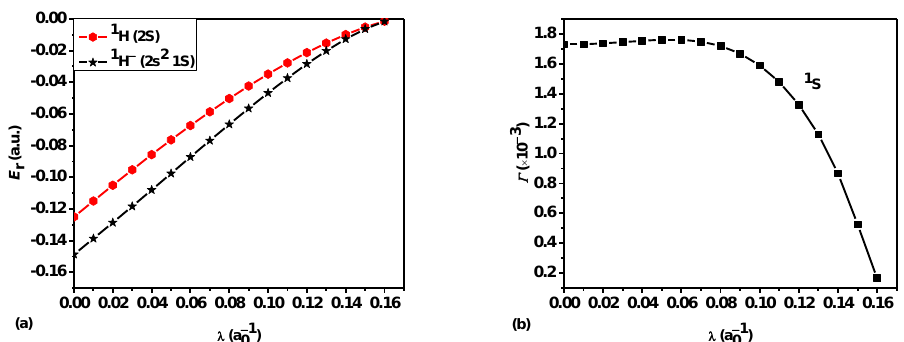
Figure 6. ( a ) Plot of the lowest 1 S e resonance energy E r of 1 H − as a function of the screening parameter λ . ( b ) Plot of the corresponding resonance width Γ of 1 H − as a function of the screening parameter λ .